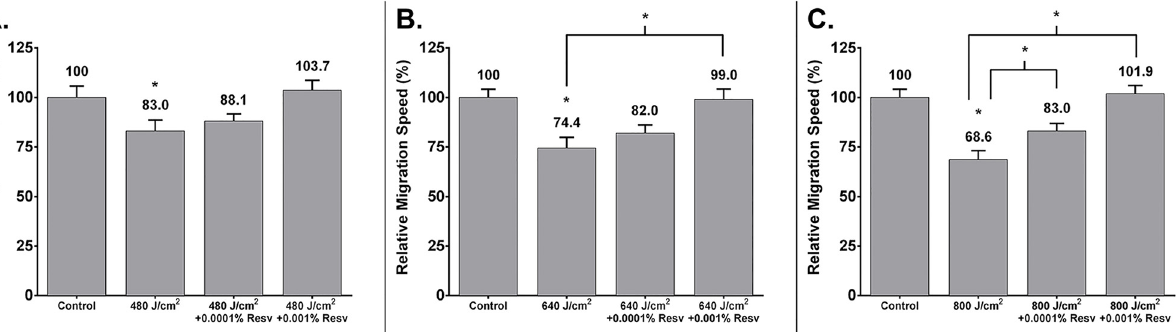
Fig 3. Light-emitting diode generated red light (LED-RL) at a fluence of 480 J/cm 2 significantly decreased relative fibroblast migration speed to 83.0 ± 5.6% (p = 0.0393) compared to matched controls (100 ± 5.8%). A. Pretreatment with 0.0001% resveratrol partially prevented LED-RL ’ s (480 J/cm 2 ) effects compared to LED-RL alone and resulted in a relative migration speed of 88.1 ± 3.5% (p = 0.4837). Pretreatment with 0.001% resveratrol partially prevented LED-RL ’ s (480 J/cm 2 ) effects compared to LED-RL alone and resulted in a relative migration speed of 103.7 ± 5.0% (p = 0.0623). Error bars represent standard error of the mean. ( * represents P < .05). Fig 3B. Light-emitting diode generated red light (LED-RL) at a fluence of 640 J/cm 2 significantly decreased relative fibroblast migration speed to 74.4 ± 5.5% (p = 0.0003) compared to matched controls (100 ± 4.2%). Pretreatment with 0.0001% resveratrol partially prevented LED-RL ’ s (640 J/cm 2 ) effects compared to LED-RL alone and resulted in a relative migration speed of 82.0 ± 4.1% (p = 0.3068). Pretreatment with 0.001% resveratrol significantly prevented LED-RL ’ s (640 J/cm 2 ) effects compared to LED-RL alone and resulted in a relative migration speed of 99.0 ± 5.3% (p = 0.0009). Error bars represent standard error of the mean. ( * represents P < .05). Fig 3C. Light-emitting diode generated red light (LED-RL) at a fluence of 800 J/cm 2 significantly decreased relative fibroblast migration speed to 68.6 ± 4.5% (p = 0.0003) compared to matched controls (100 ± 4.2%). Pretreatment with 0.0001% resveratrol significantly prevented LED-RL ’ s (800 J/cm 2 ) effects compared to LED-RL alone and resulted in a relative migration speed of 83.0 ± 3.9% (p = 0.019). Pretreatment with 0.001% resveratrol significantly prevented LED-RL ’ s (800 J/cm 2 ) effects compared to LED-RL alone and resulted in a relative migration speed of 101.9 ± 4.2% (p = 0.0006). Error bars represent standard error of the mean. ( * represents P < .05).